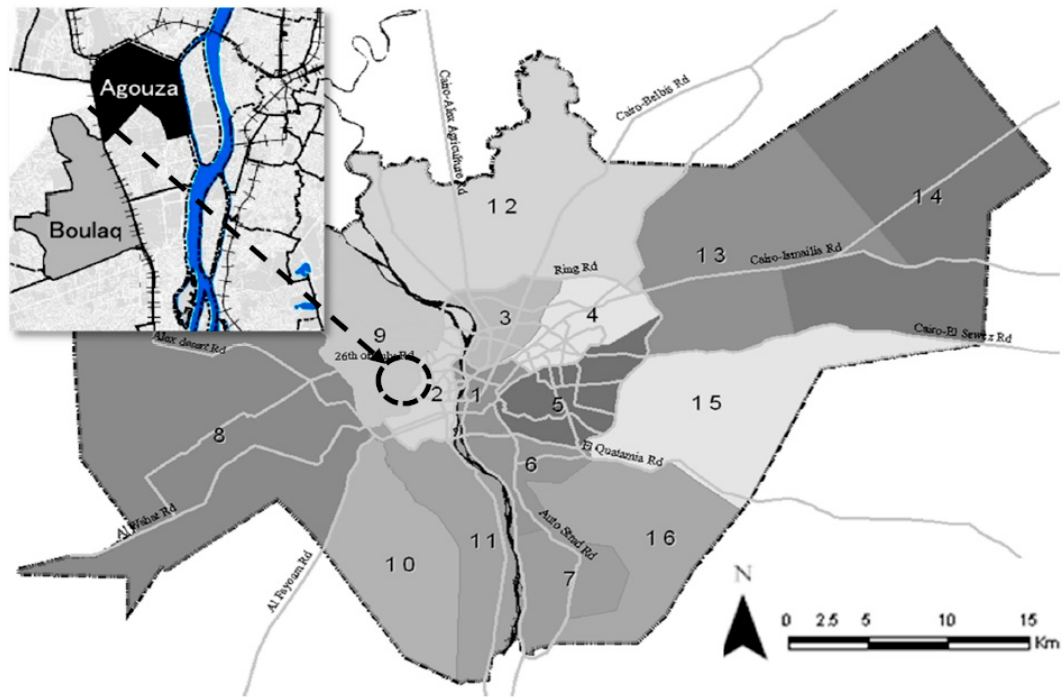
Figure 2. Location of research samples within GCMR planning Zones, Source: JICA, 2008 [49] with authors’ modifications.